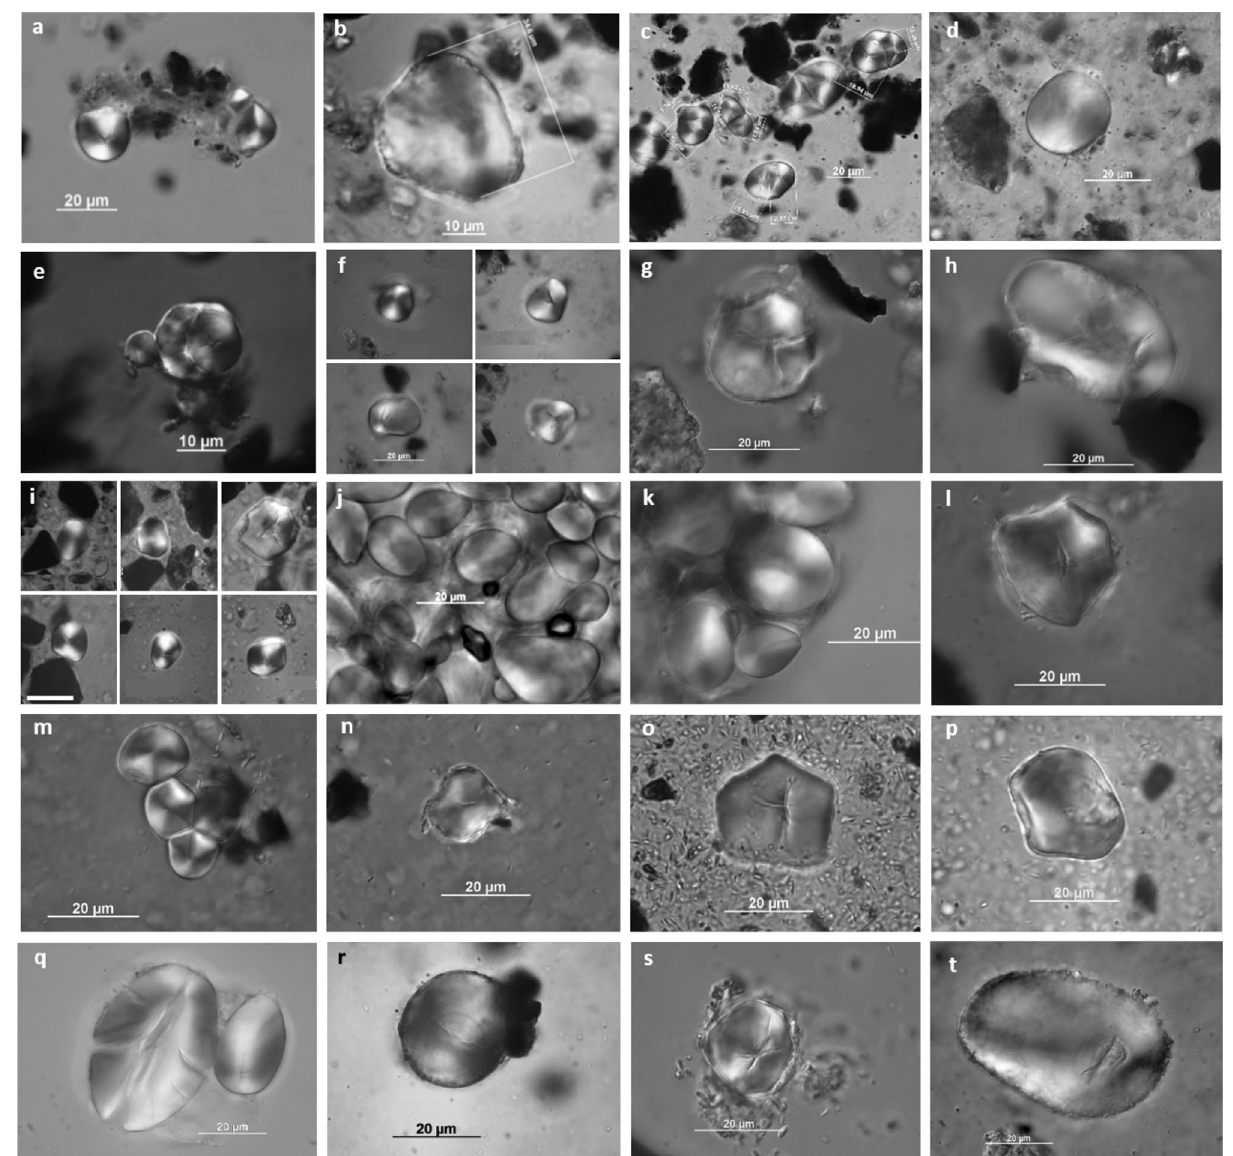
Figure 6. Examples of starch grains recovered from grinding stones from Madjedbebe submitted for starch grain analysis. Phase 7: ( a , b ) L49; ( c ) UPGS2. Phase 6: ( d ) UPGS4. Phase 5: ( e ) GS3. Phase 4: ( f ) UPGS14. Phase 3: ( g , h ) UPGS32. Phase 2: ( i ) GS9; ( j – l ) GS40; ( m , n ) GS48; ( o , p ) GS73; ( q , r ) GS 74; ( s , t )